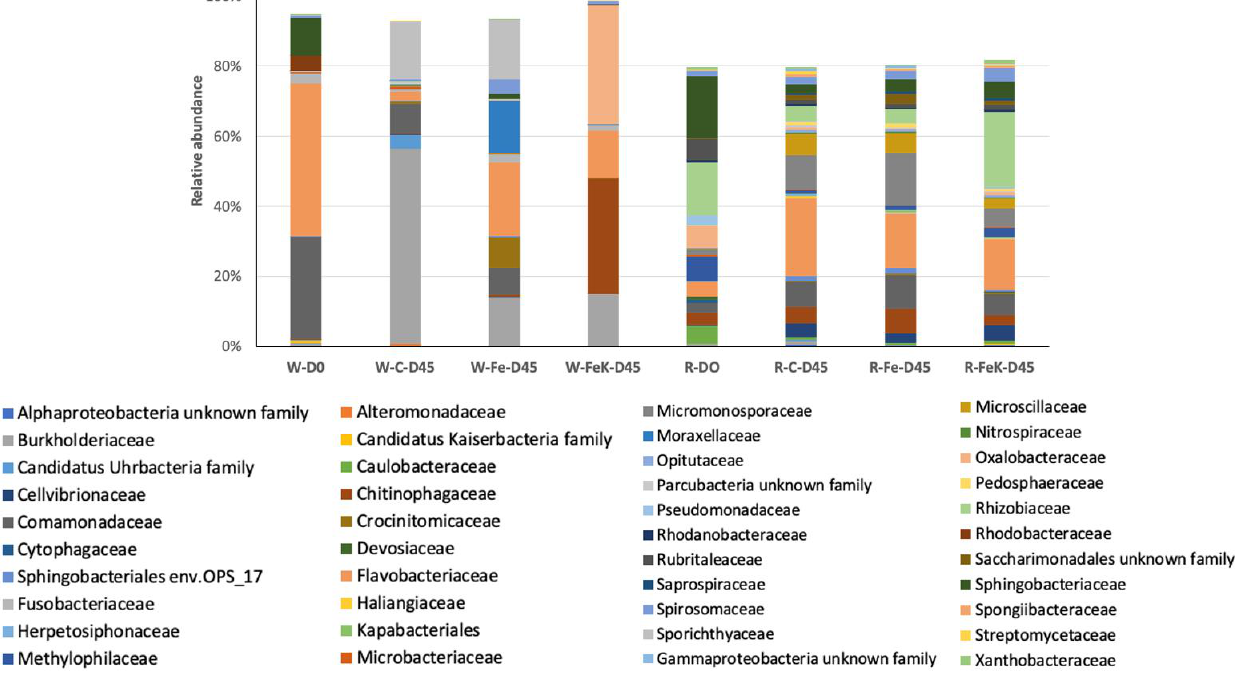
Figure 8. The most dominant bacterial families (cumulative relative abundance ≥80% in the aver- aged sample). W: water; R: root; C: control; Fe: iron; K: potassium; D0: the first sampling just before the commencement of the experiment; D45: the second sampling at the 45th day of the experiment.